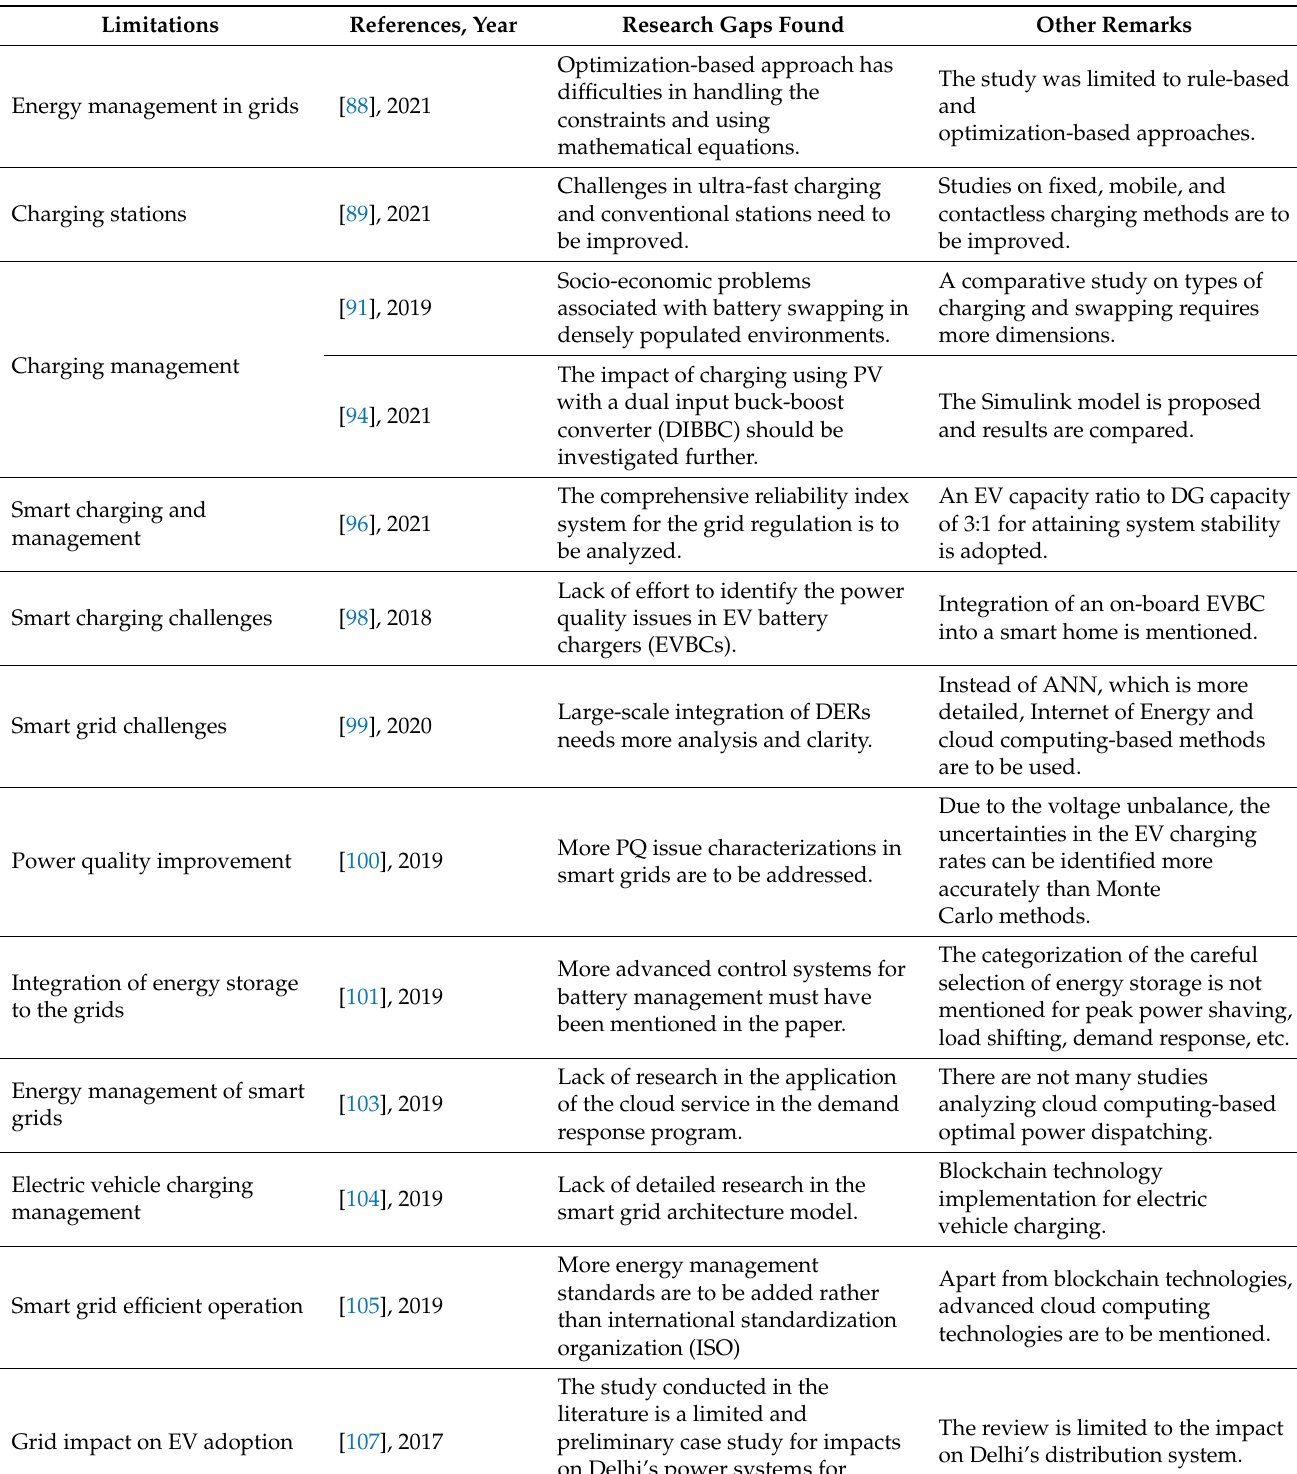
Table 4. Limitations of electric vehicle grid integration as per the recent